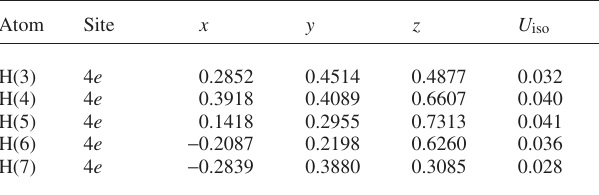
Table 2. Atomic coordinates and displacement parameters (in Å 2 )